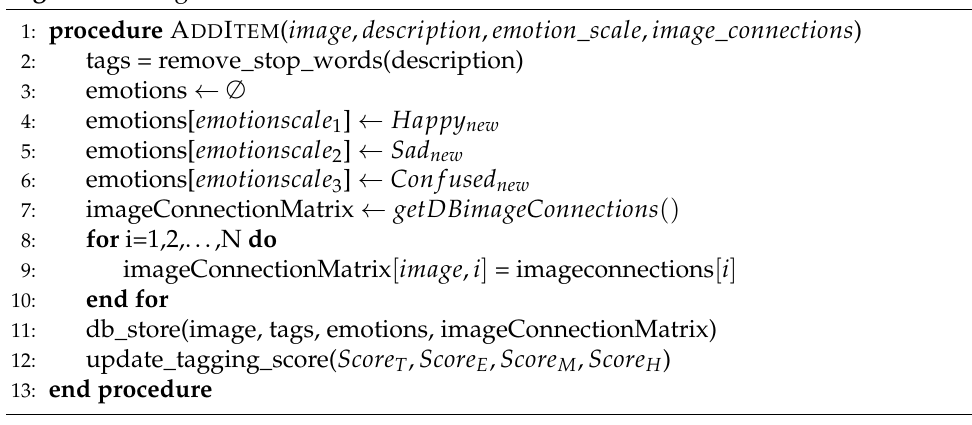
Algorithm 1 Tagasaurus Item